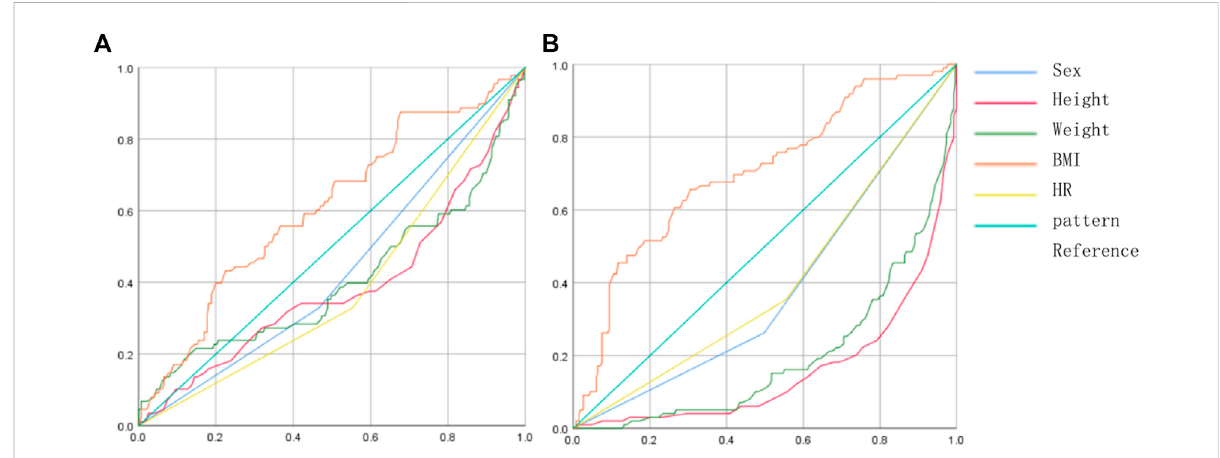
FIGURE 5 ROC curves ofBMIand aEMGoftheSPL andSCM. (A) ROC curvesof thefactorsandSPL aEMG, theorangecolor representedtheBMI; (B) ROC curves of the factors and SCM aEMG, the orange color represented the